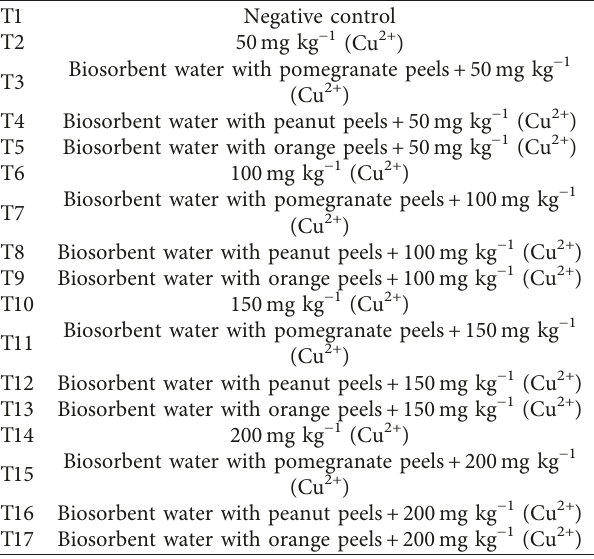
Table 1: Experimental layout: experimental work was placed in two sections with 17 treatments.